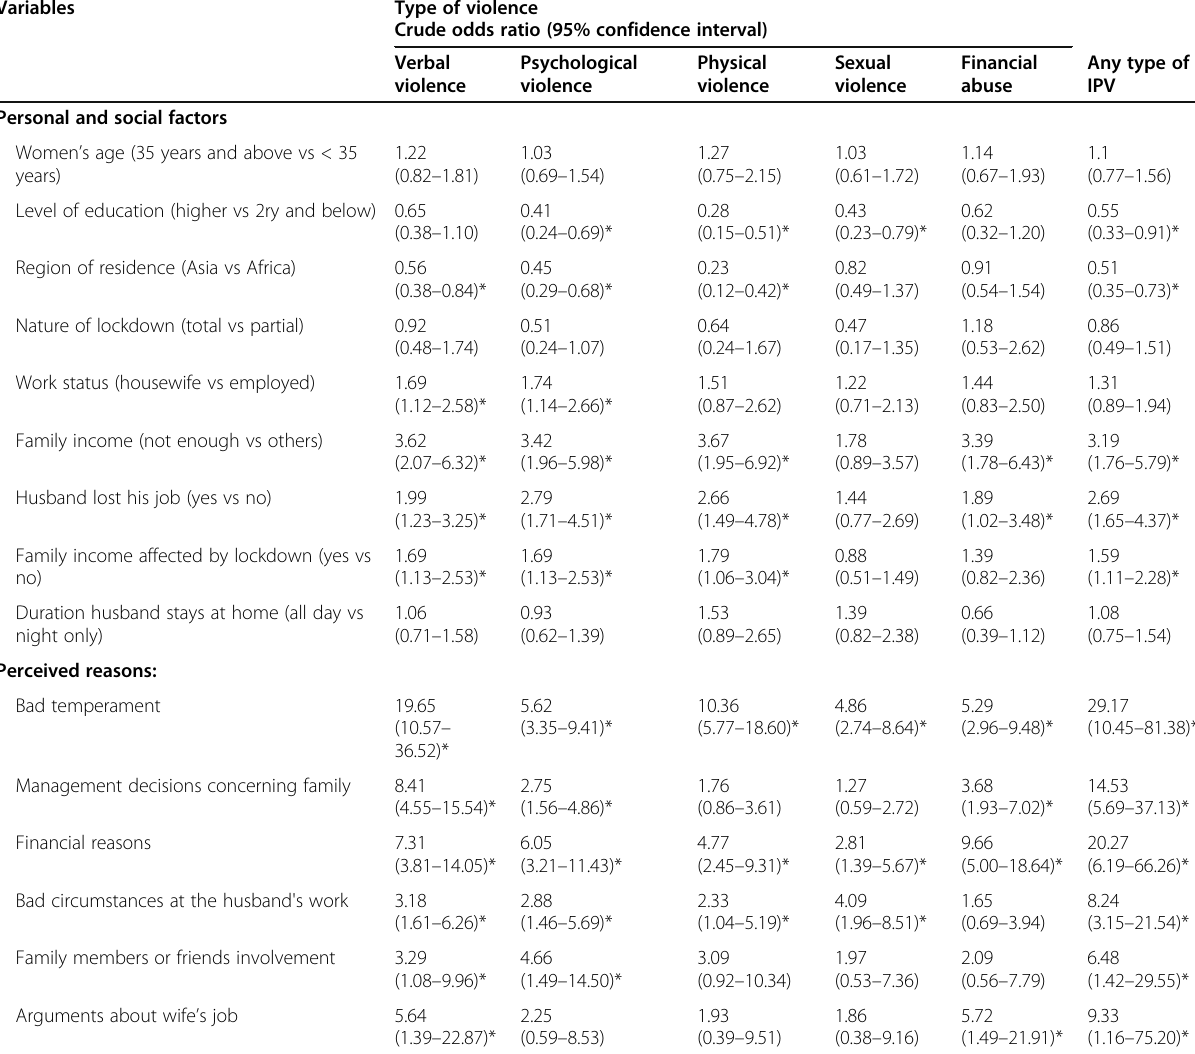
Table 3 Crude odds ratio of the different types of IPV among adult Arab women during lockdown and their personal and social characteristics and the perceived reasons for exposure